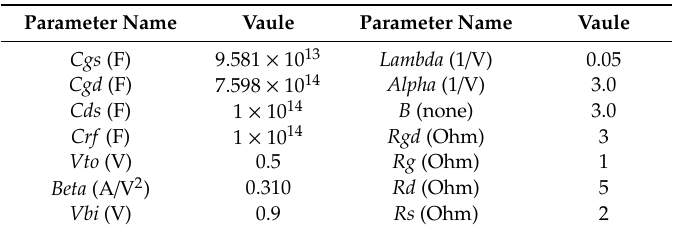
Table 1. Parameters for Statz model.